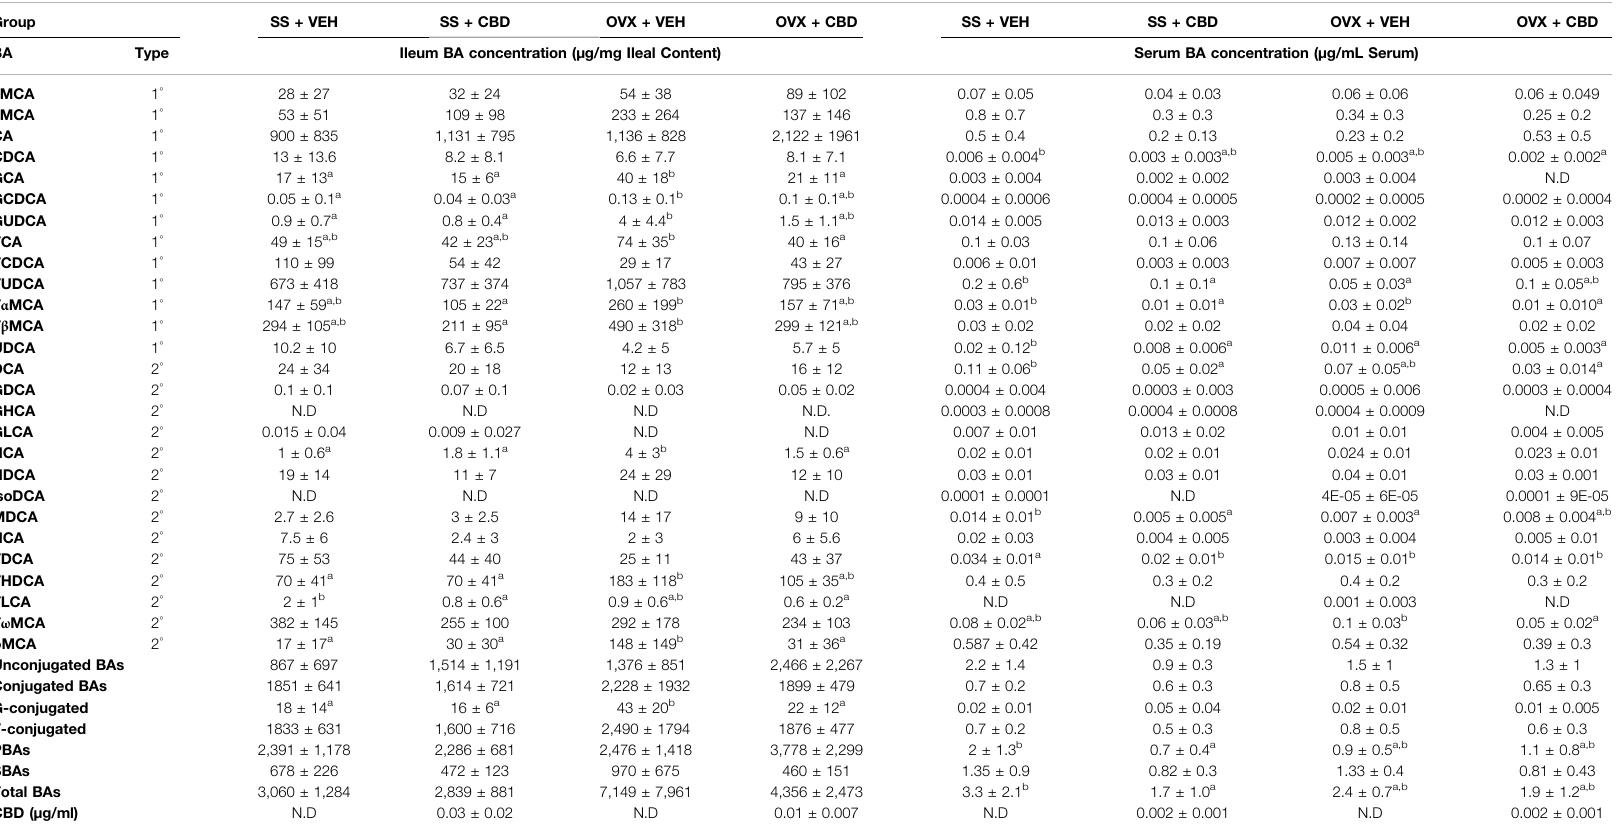
TABLE 1 | Bile acid concentrations in ileal content and serum.